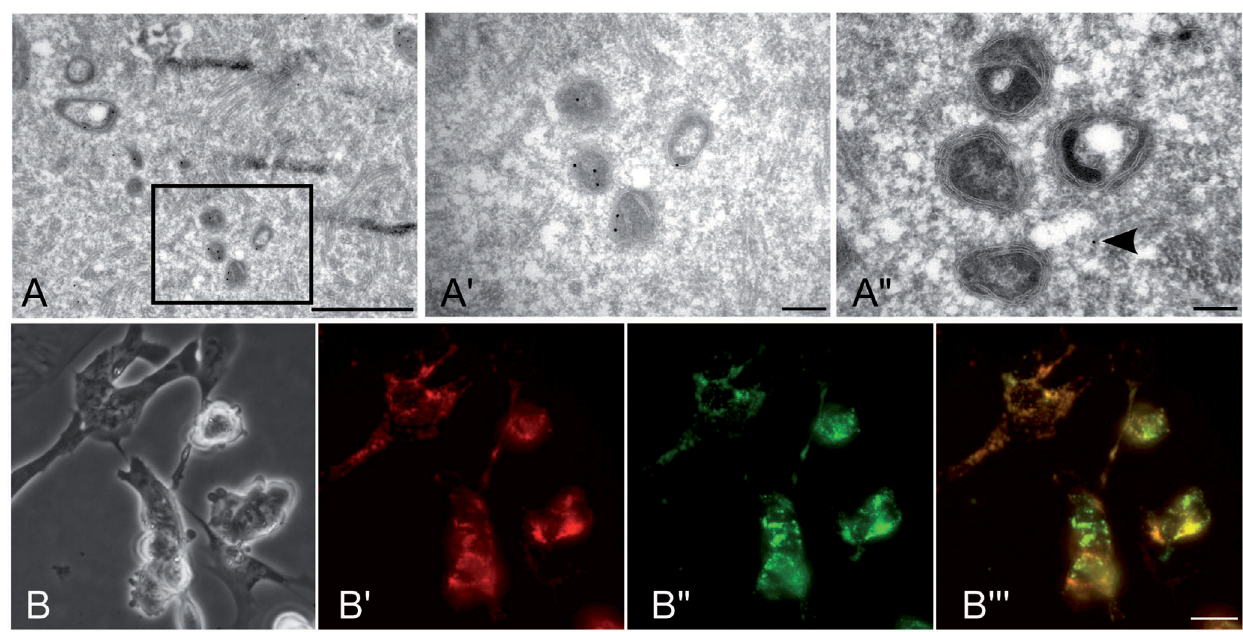
Figure 1. EGFP localization in mtGFP-Tg cells. (A) In the mtGFP-Tg oocyte, EGFP is mainly localized in mitochondria (A’, insert in A), as shown by cryo-immuno electron microscopy. (A’’) In cryosections of B6C3F1 wild-type ooplast (SCNT recipient), only low unspecific background labeling in the cytoplasm is found (arrow), while there is no detectable mitochondrial signal. Scale bar, A: 1 m m; A’ and A’’: 200 nm. (B) Embryonic stem cells (here feeder-free) derived from fertilized blastocysts express EGFP (B’’, green), co-localizing with mitochondria (stained with TMRM; B’, red); B’’’, merge B’ and B’’. Scale bar, 25 m m.